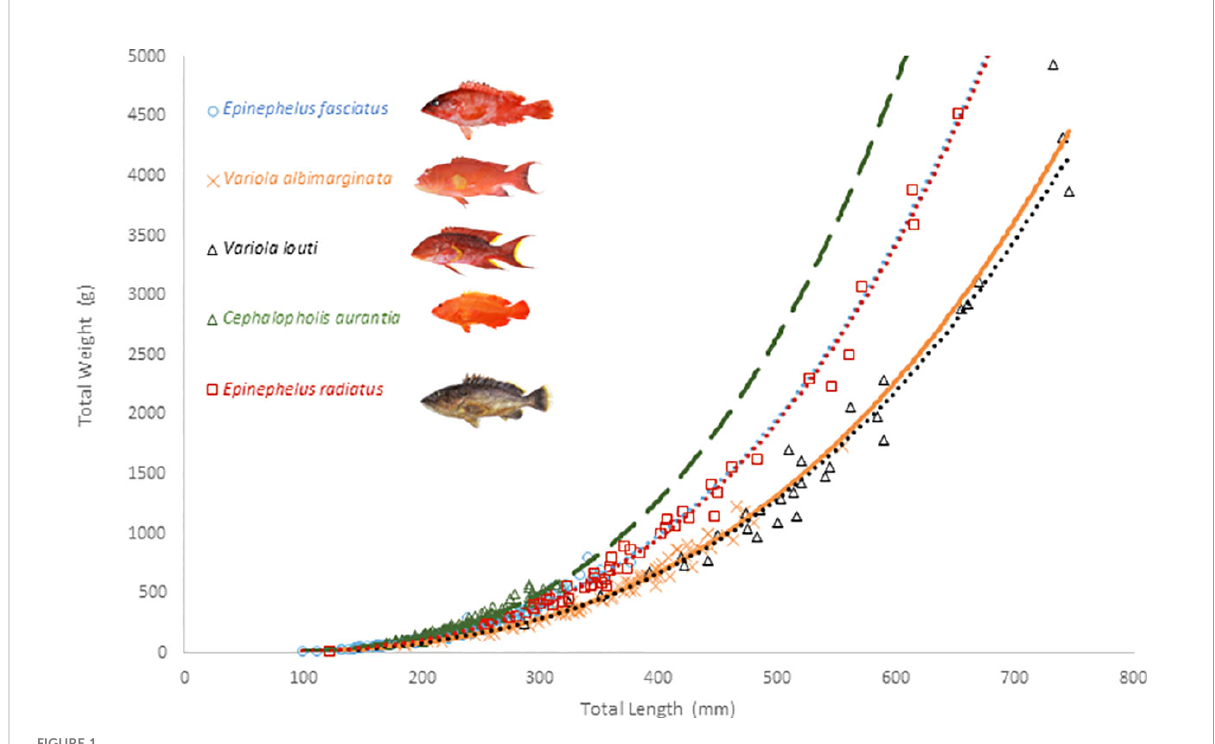
FIGURE 1 Total Length/Total Weight relationship of grouper species around La Re ́ union